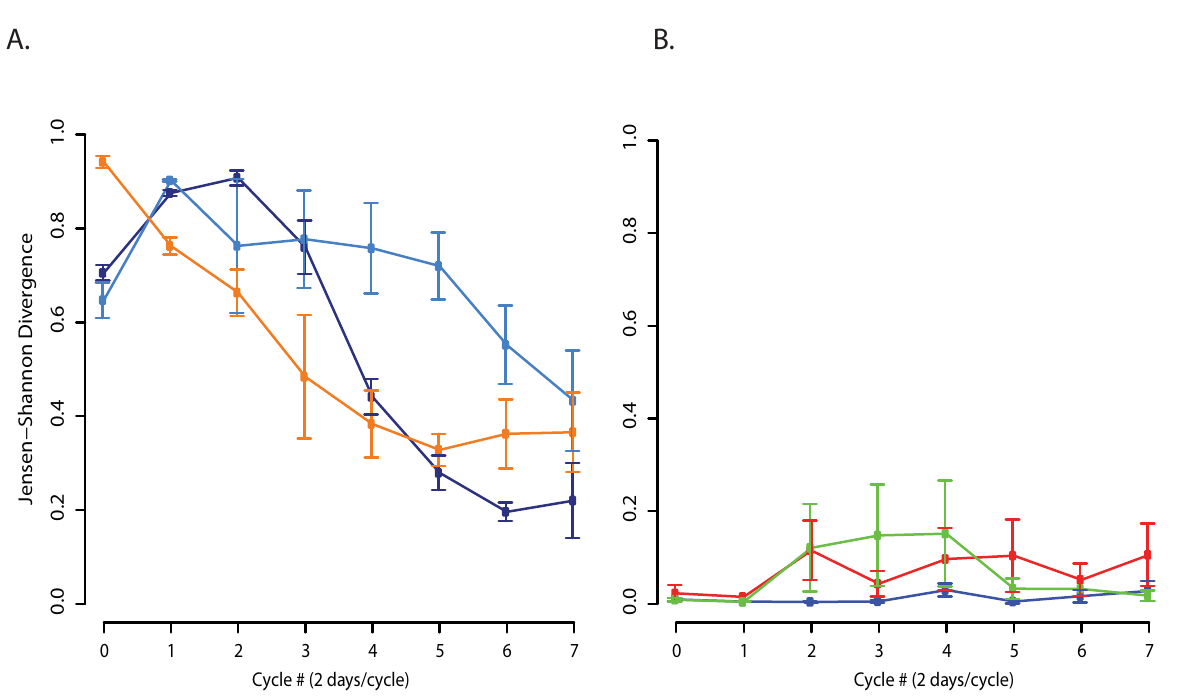
Fig 3. Divergence between reactorsdecreasesovertime but remains low between replicates of the same inoculum. A) Average pairwise Jensen-Shannondivergence (family level) betweenMangroveand Camel (dark blue), Mangroveand Sludge(light blue), and Sludgeand Camel (orange) bioreactors. B) Average pairwiseJensen-Shannon divergence(family level) betweenCamel (blue), Mangrove(red), and Sludge(green)replicatebioreactors.